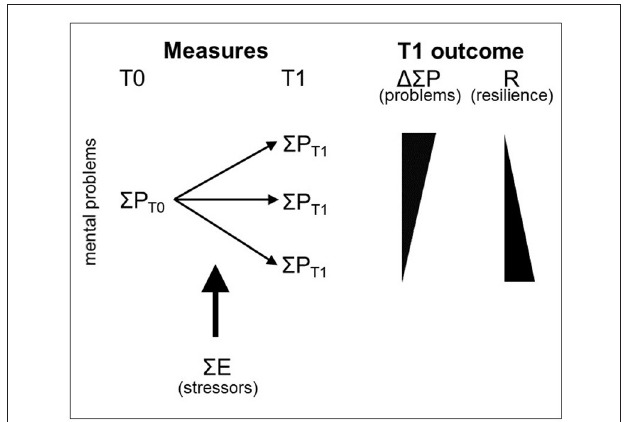
FIGURE 2 | Outcome-based quantification of resilience. Kalisch et al. (2015) proposed to quantify resilience (R) as the ratio of changes in mental health problems P from before (T0) to after (T1) stressor exposure E. Stressors are summed over the observation period (from T0 to T1). Adapted from Kalisch et al. (2015) (their Figure 1 ). Reproduced with